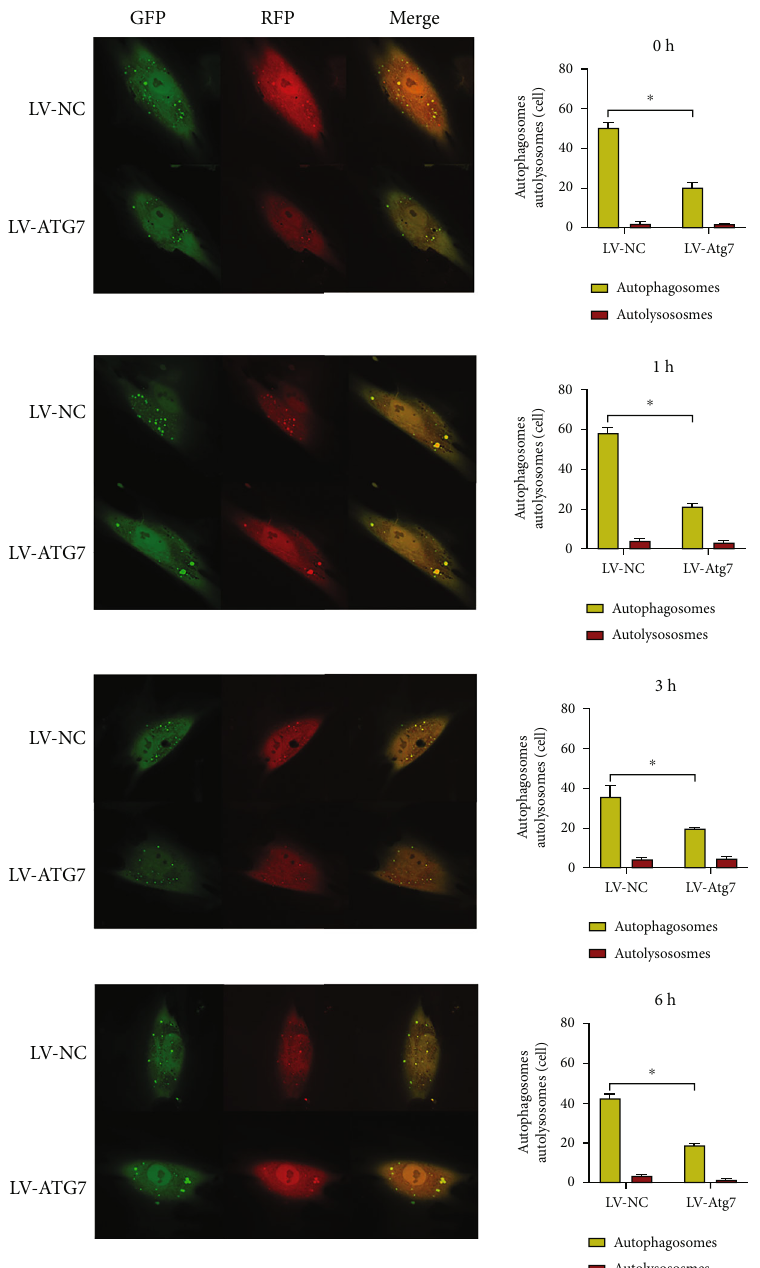
Figure 6: The detection of autophagy fl ux after knocking down the autophagy-related gene ATG7. GFP: green fl uorescent protein; RFP: red fl uorescent